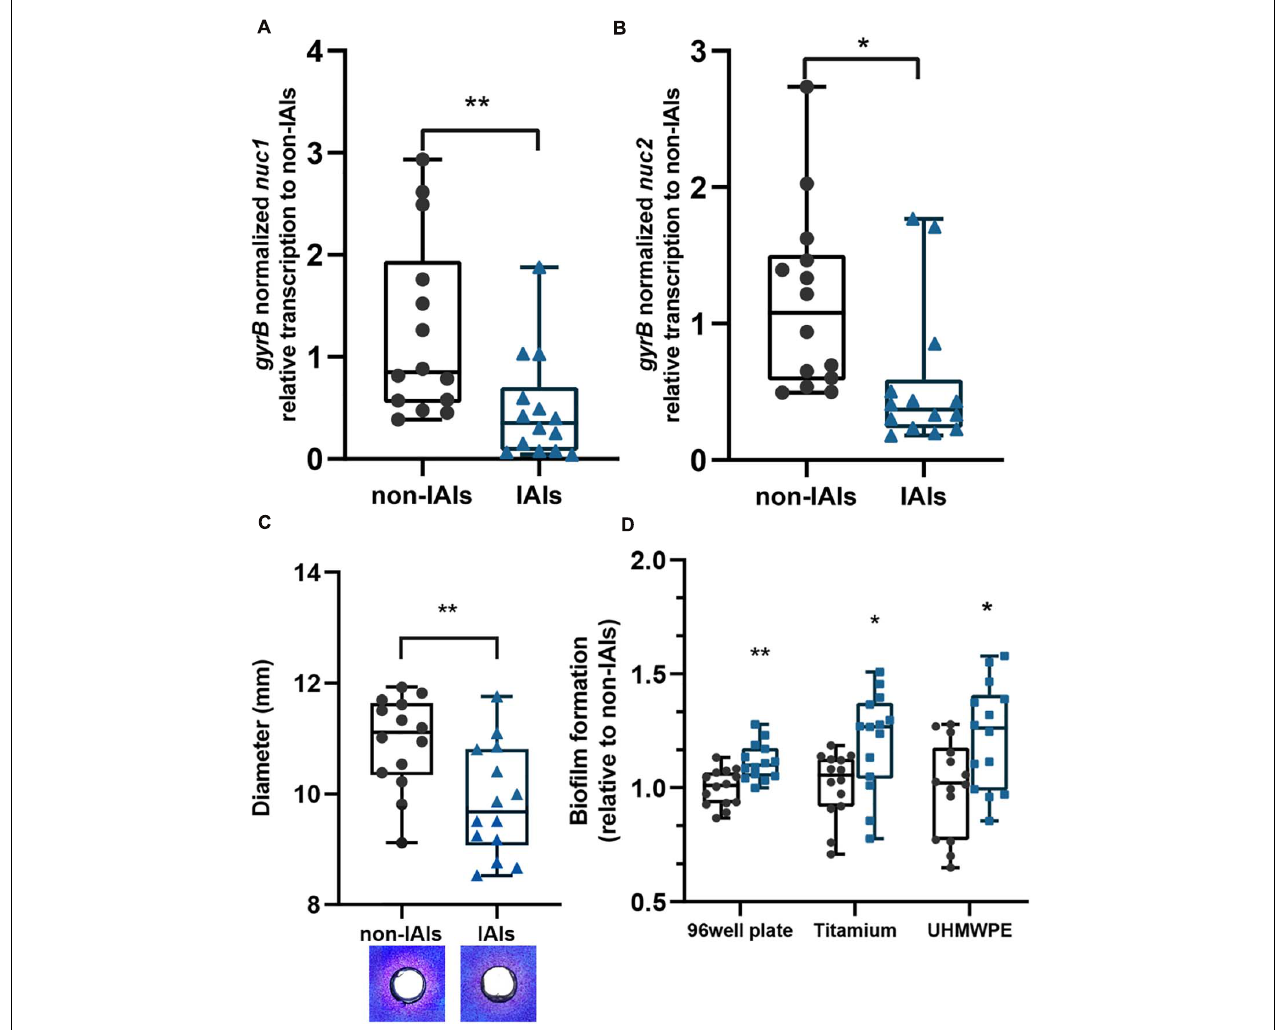
FIGURE 1 | The expression levels of thermonucleases and biofilm-forming ability in clinical isolates. Expression of nuc1 (A) and nuc2 (B) in IAI and non-IAI isolates ( n = 14/group) determined by qPCR. (C) Nuclease activity in toluidine blue DNA agar represented in the diameter of red zones. Representative images are also presented. Red zones indicate nuclease activity. (D) Biofilm formation of IAI ( n = 14) and non-IAI isolates ( n = 14) on different materials including polypropylene 96-well plates (non-IAIs = 1.334 ± 0.103), titanium disk (non-IAIs = 1.664 ± 0.229), and UHMWPE (non-IAI = 1.407 ± 0.284). Biofilm biomass was stained with crystal violet. Statistical significance was calculated using two-tail Student’s t -test in panels (A – C) ; the multiple t -test (Bonferroni–Dunn’s test) was used in panel (D) . * p < 0.05; ** p < 0.01 vs. non-IAI